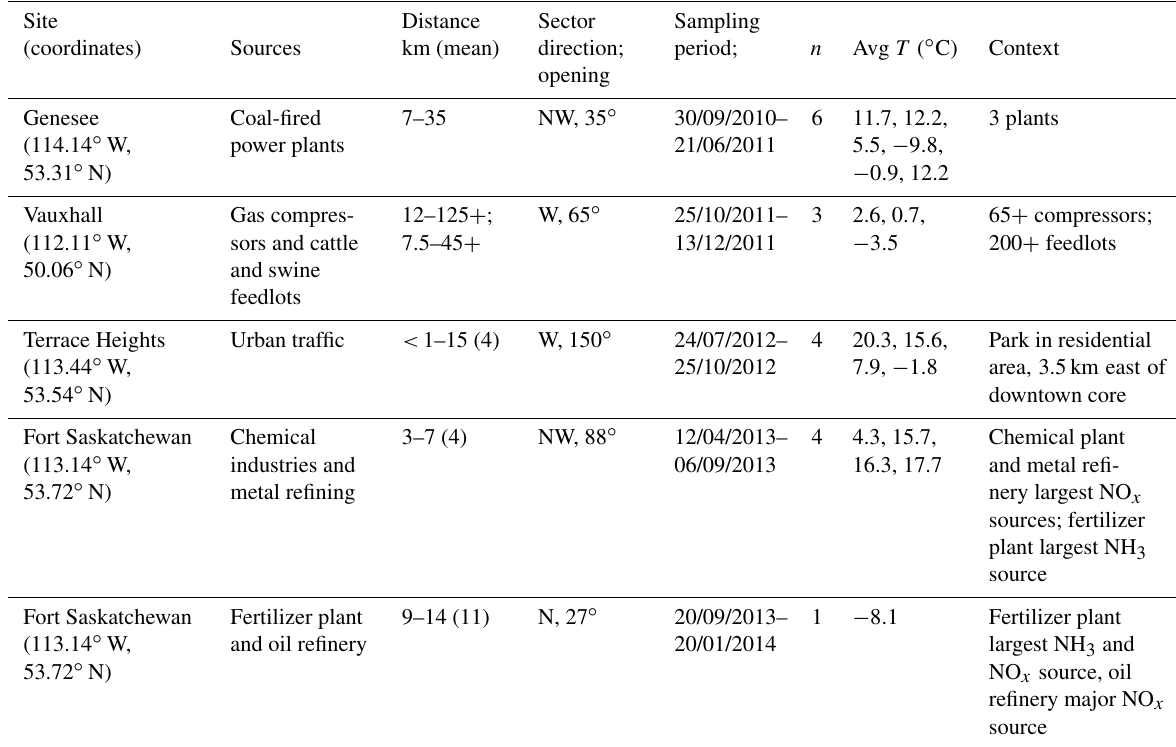
Table 1. Settings and conditions for wind-sector-based simultaneous sampling of atmospheric